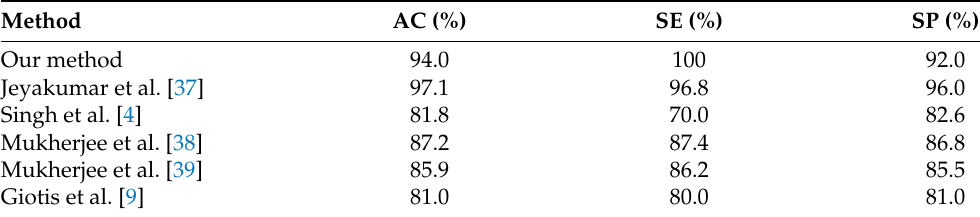
Table 2. Qualitative performance comparison of the proposed framework with various state-of-the-art methods using the public MED-NODE skin lesion